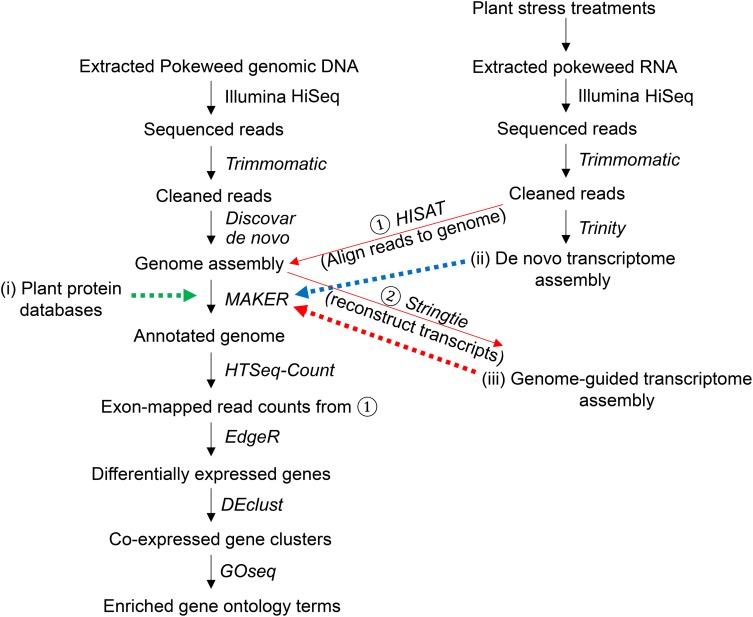
Summary of genome assembly, annotation, and differential gene expression analysis. The assembled pokeweed genome was annotated using three sources of information provided to MAKER, indicated with dashed arrows: (i) published plant protein databases, (ii) the pokeweed de novo transcriptome assembly, (iii) the pokeweed genome-guided transcriptome assembly, derived from aligning unassembled (‘cleaned’) reads to the genome (①) and joining exonic regions into transcripts (②). Reads from (①) that aligned to exonic regions of a gene (defined by the annotated gene models) were summed. Counts were used as input for differential gene expression analysis. The top differentially expressed genes were clustered, and functional enrichment testing was performed on each cluster.